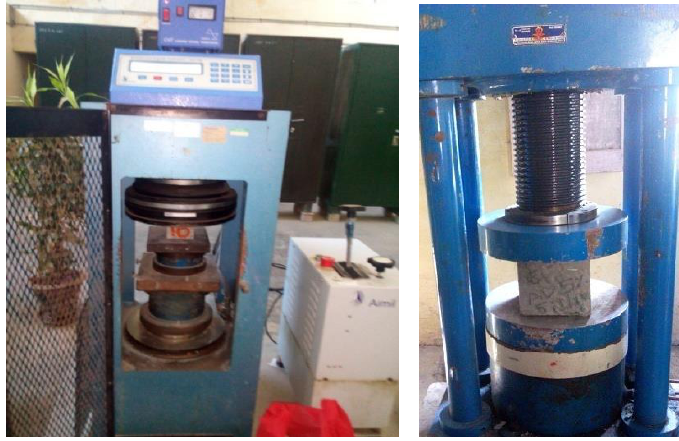
Figure 9. Mortar cube compressive strength test.